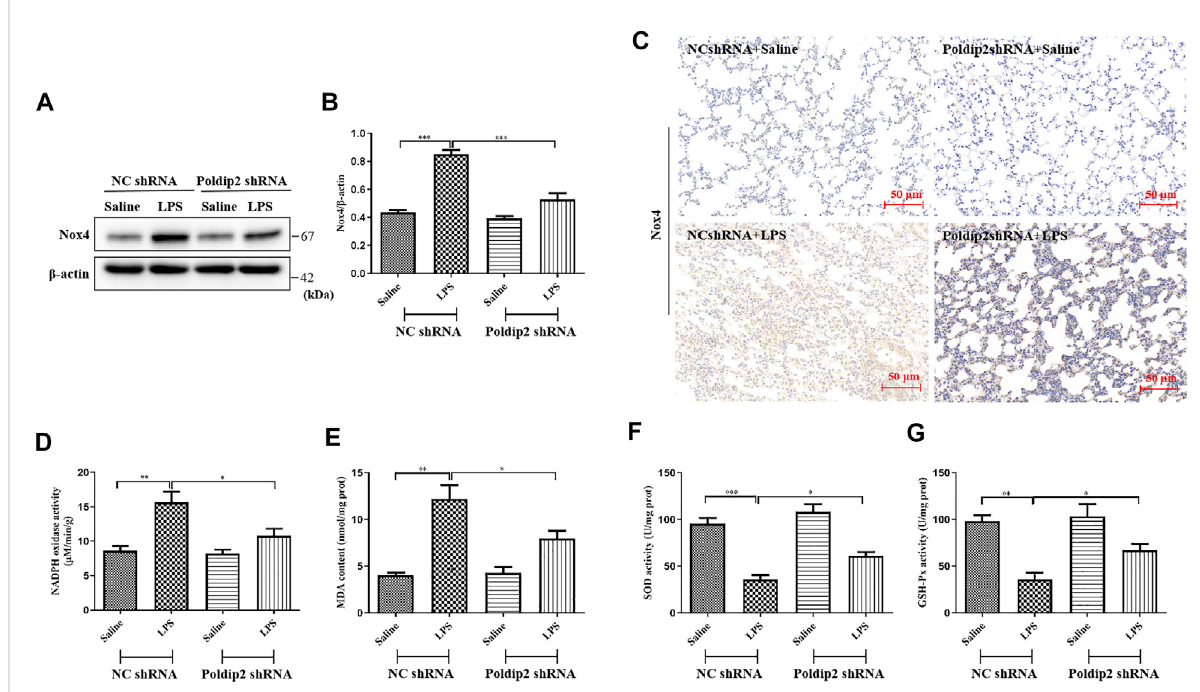
FIGURE 2 Poldip2 knockdown suppresses oxidative stress in LPS-induced mice ALI. (A) Male C57BL/6 mice were intratracheally atomized with AAV6 vector expressing Poldip2 shRNA or NC shRNA. Thirty- fi ve days later, 5 mg/kg of LPS or saline was given via intratracheal atomization for 24 h (A,B) The protein level of Nox4 were detected by western blot (A) and quantitatively analyzed (B) (C) Representative images showing immunohistological staning of Nox4 in lung tissue sections (magni fi cation, ×200). Scale bars are 50 µm (D) The NADPH oxidase activity in lung homogenates was detected by spectrophotometer. (E – G) The MDA concentrations and SOD and GSH-Px activities in lung homogenates were determined. n =6micepergroup.Resultsarerepresentedasmean±SEM.Statisticallysigni fi cantdifferencesareindicatedas*** p < 0.001,** p < 0.01, * p <